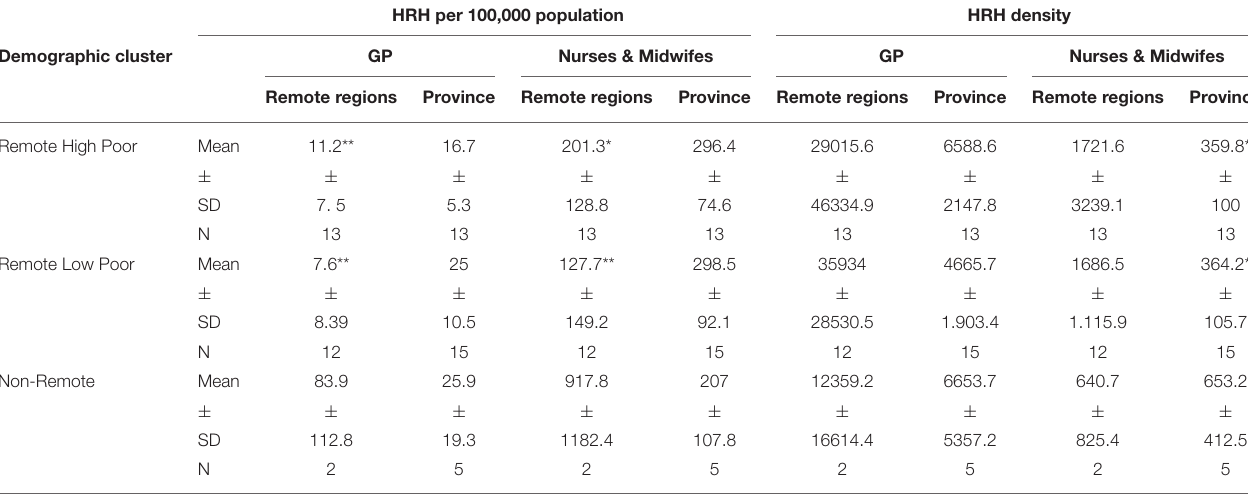
TABLE 1 | Human resources for healthcare (HRH) in entire provinces and remote regions, given as HRH per 100,000 population and HRH density (covered population per HRH) for general practitioners (GP) and